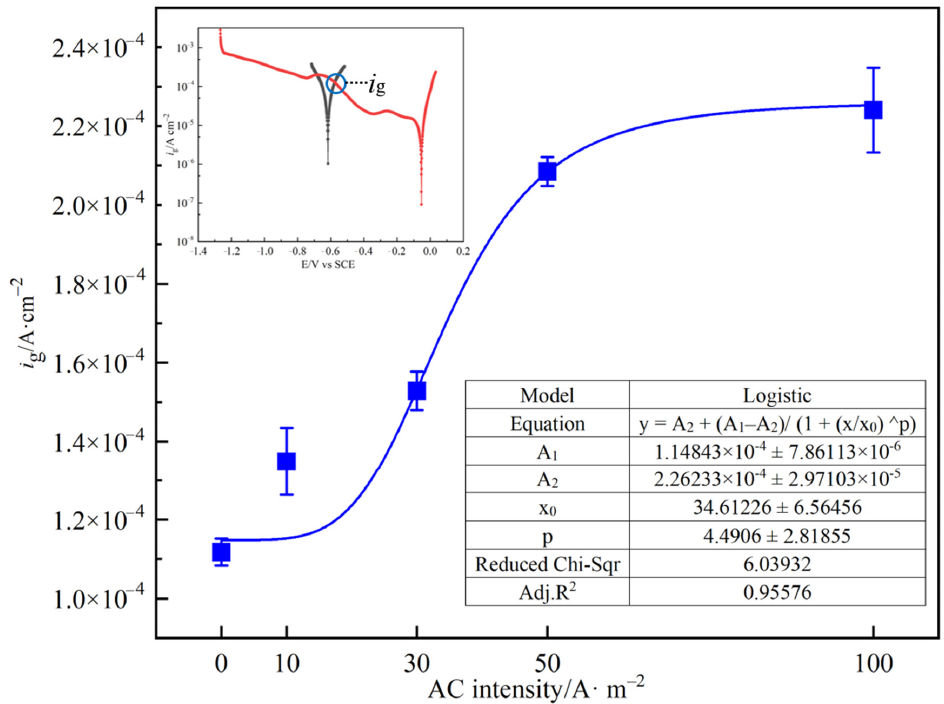
Figure 12. The curves of fitted i g varied with different AC intensities. i g represents the galvanic current of steel–copper couples and is calculated based on potentiodynamic polarization curves (as shown in inset figure).